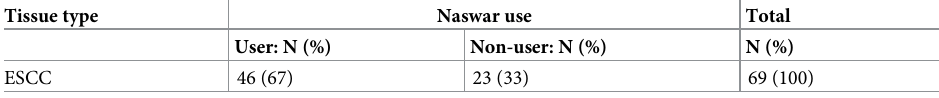
Table 1. Frequency of naswar use in esophageal squamous cell carcinoma in Khyber Pakhtunkhwa region of Pakistan. Tissue type